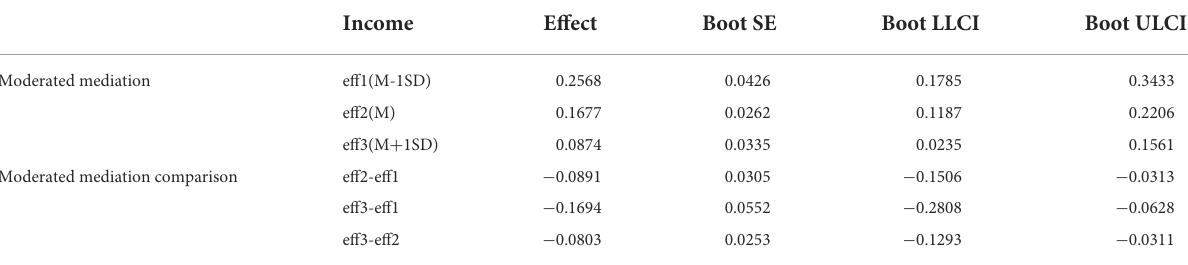
TABLE 11 Mediating effect at different income